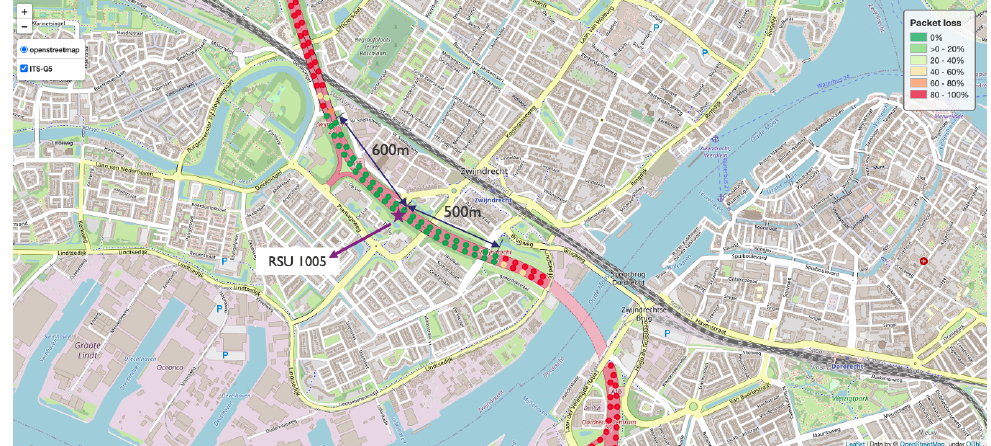
Figure 7. Packet loss over ITS-G5 between the Belgian vehicle and a Dutch RSU at the Amsterdam pilot